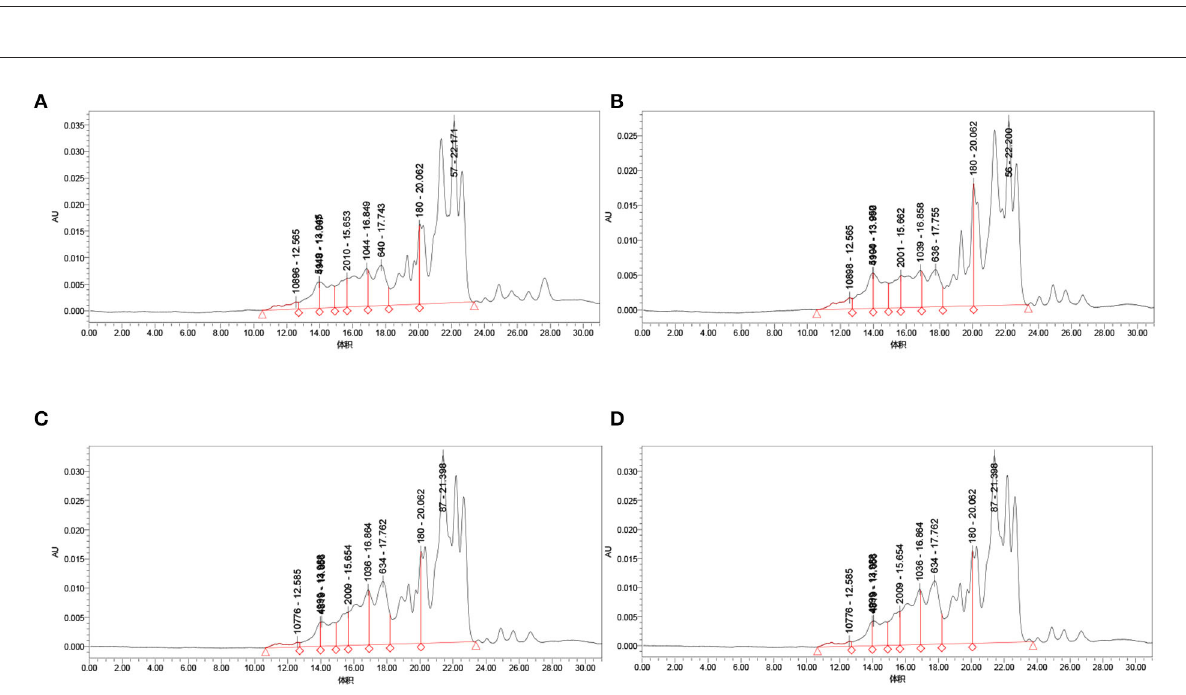
FIGURE4 Molecular weight distribution of fermentation peptides of four strains. (A) Molecular weight distribution of Bifidobacterium species fermentation peptide; (B) Lactobacillus acidophilus molecular weight distribution of fermentation peptide; (C) Lactobacillus rhamnosus fermentation peptide; and (D) Lactobacillus paracasei fermentation